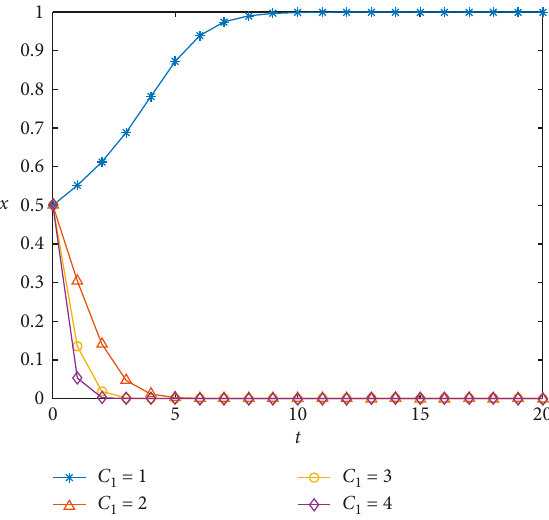
Figure 5: Influences of the cost C 0 on the